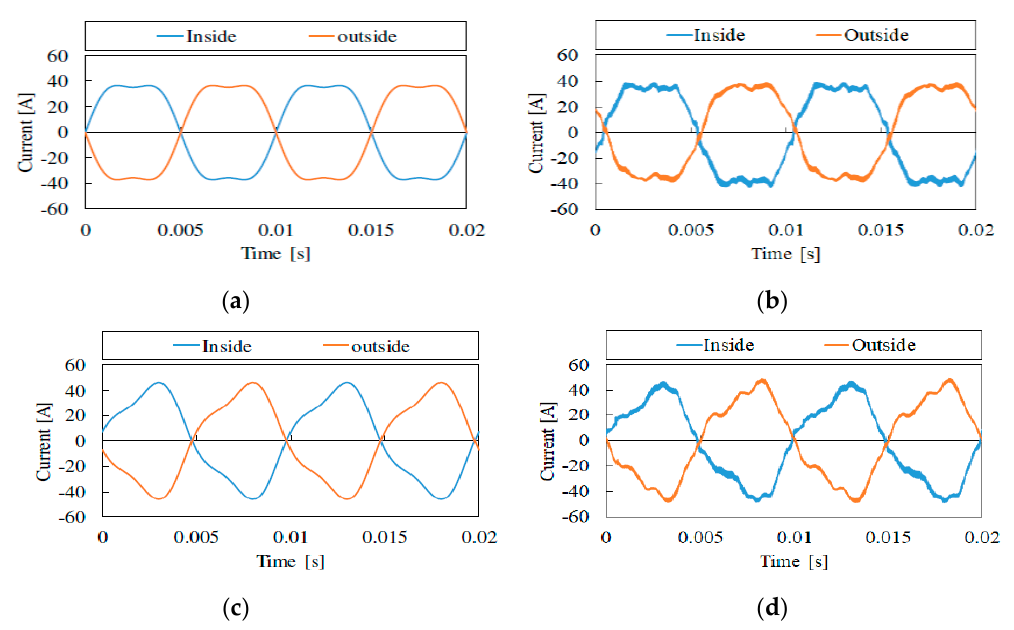
Figure 20. Measured current waveforms with 3rd harmonics current injection. Fundamental current amplitude is 30 Arms, 3rd harmonics current amplitude is 5 Arms. ( a ) Current reference of 3rd harmonics current injection, the phase is 0 deg. ( b ) Measured current of 3rd harmonics current injection, the phase is 0 deg. ( c ) Current reference of 3rd harmonics current injection, the phase is 90 deg. ( d ) Measured current of 3rd harmonics current injection, the phase is 90 deg.